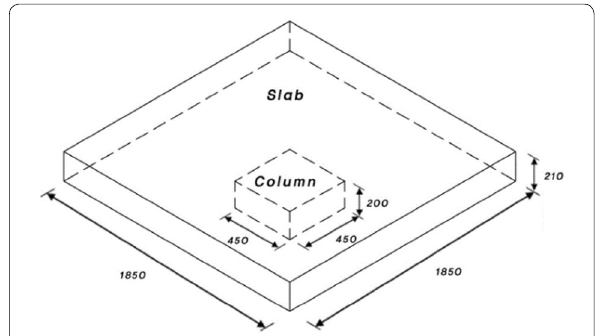
Fig. 1 Configuration of slab–column connection